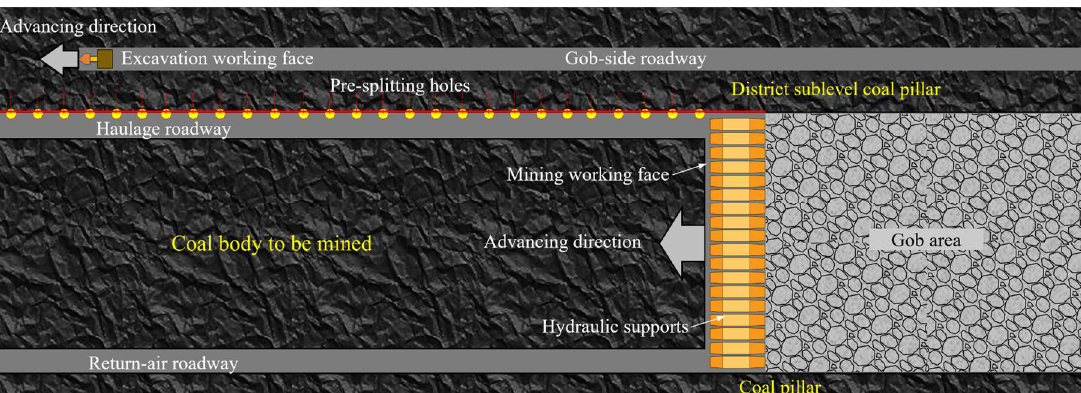
Figure 16. Pressure relief technology of roof-cutting for large deformation of roadway along goaf.